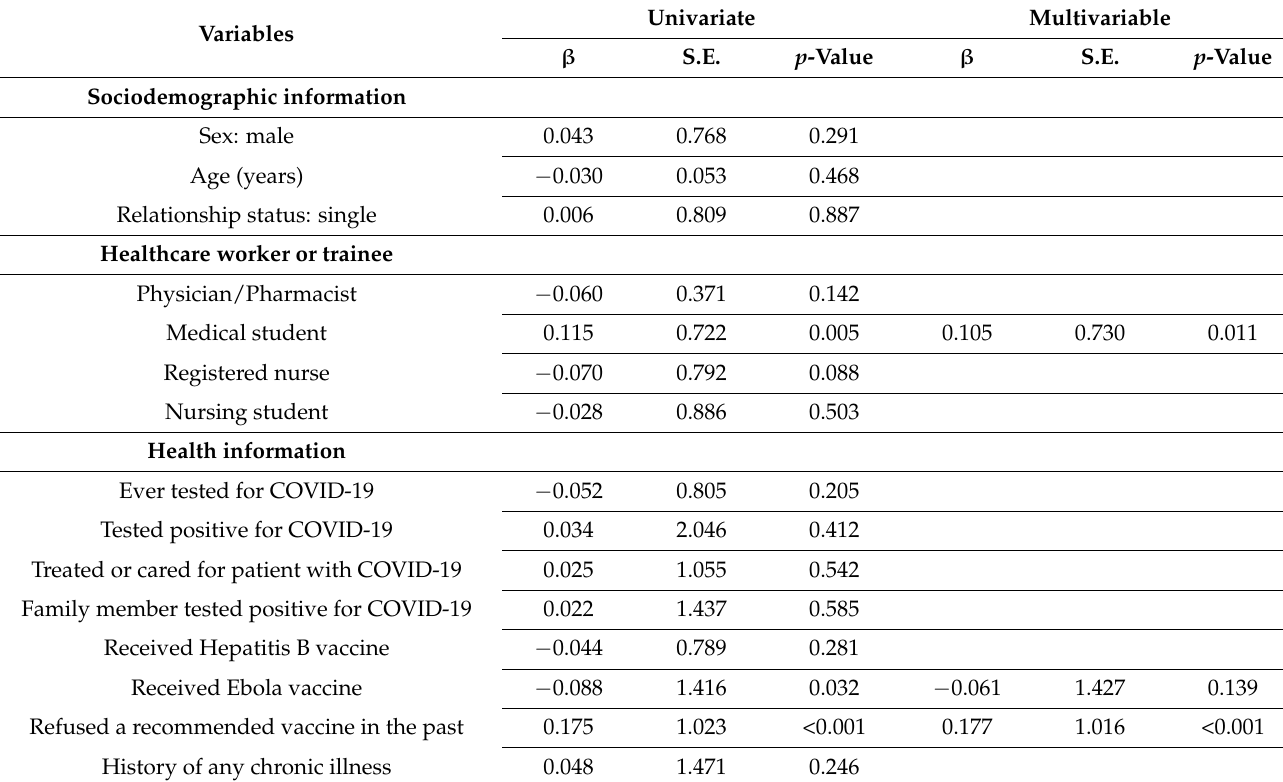
Table 4. Univariate and multivariable linear regression correlates of COVID-19 vaccine